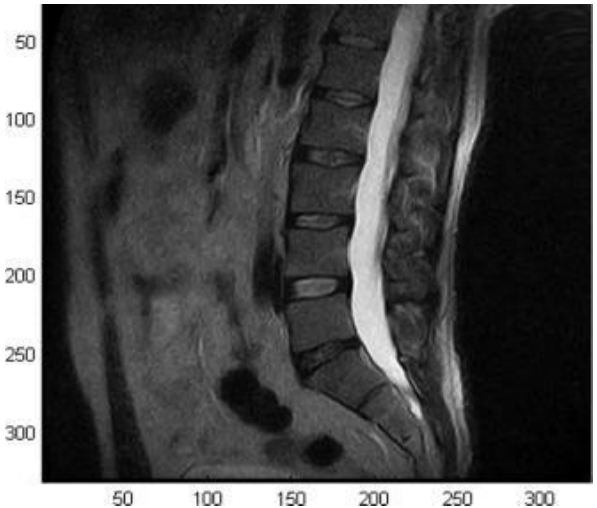
Figure 7. MR image of the spinal column of a volunteer (sagittal view) acquired with the spine volume coil. Reprinted from [42].